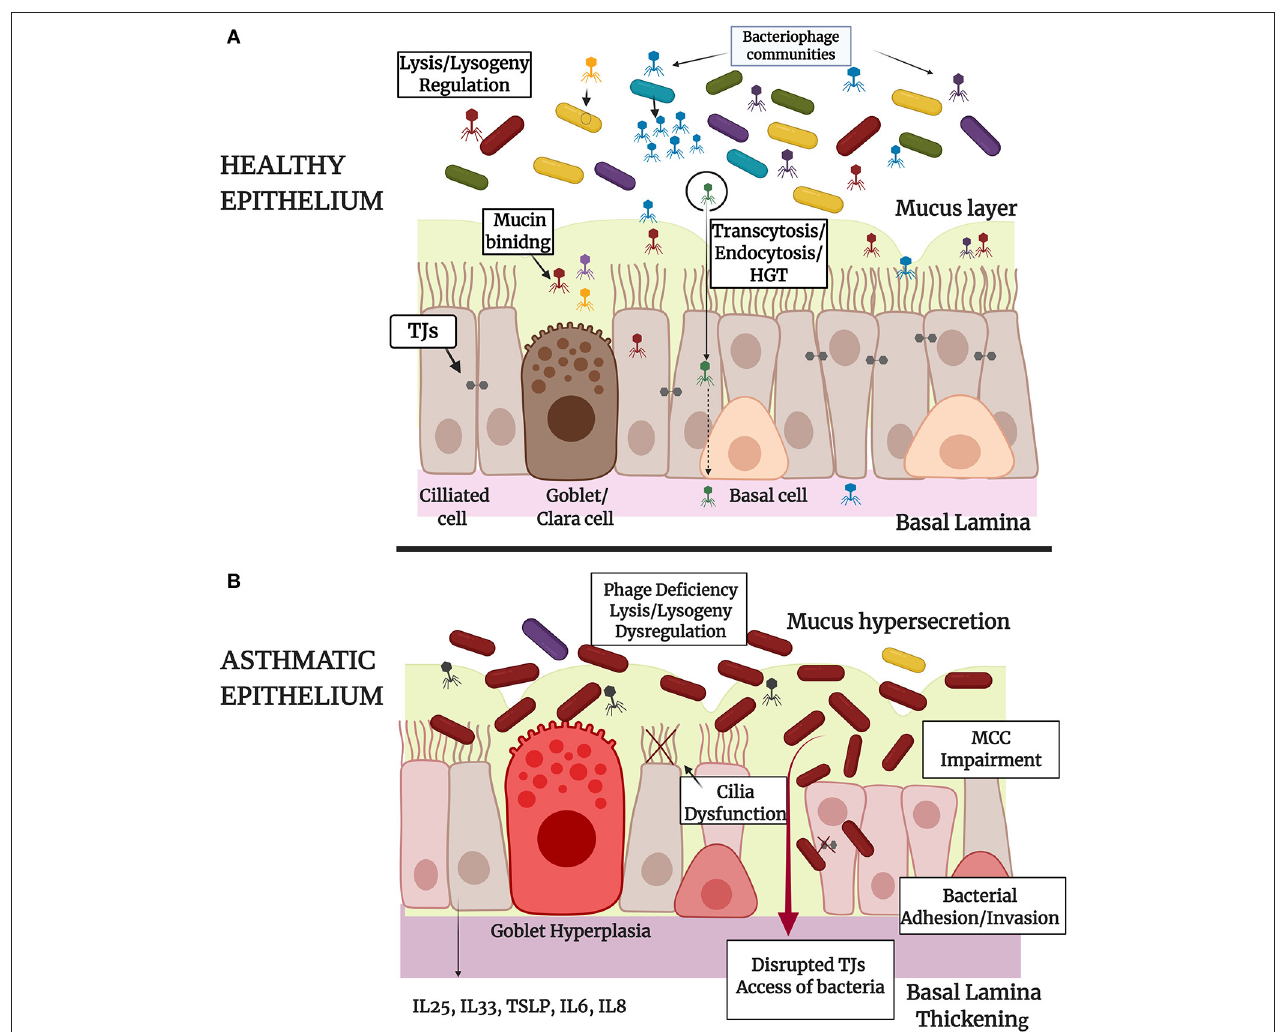
FIGURE 1 | Schematic representation of the tripartite symbiosis model between bacteriophages, bacteria and epithelium within healthy (A) and asthmatic (B) airways. (A) Healthy epithelium of large and small airways of the lungs is constituted by basal, ciliated and secretory Goblet (large airways) or Clara cells (small airways) that form pseudostratified or columnar and cuboidal structures, respectively. Epithelial barrier integrity is ensured by the formation of intracellular Tight Junctions (TJs) and by the secretion of mucus by Goblet or Clara cells. Healthy epithelium physically controls bacterial populations and eliminates bacterial invasion through mucociliary clearance (MCC). In healthy airways there is a diverse population of bacteria and bacteriophage communities that interact directly through lysis-lysogeny mechanisms and horizontal gene transfer as represented in the figure. Bacteriophages interact also directly with epithelium through adhesion to mucus or through specifically biding to cellular receptors (endocytosis) and non-specific binding to membrane vesicles (transcytosis). Bacteriophage-epithelium uptake protects the cells from bacterial invasion and proliferation and enables the delivery of bacteriophage nucleic acids (HGT) and proteins into the nucleus. (B) Asthmatic epithelium is characterized by Goblet hyperplasia, mucus hypersecretion, MCC impairment and disrupted TJs that lead to bacterial adherence and invasion into the human cells or access of bacteria into the lamina paracellularly. In the case of asthma, bacteriophage communities are deregulated, as it is presented in the figure, and this may be associated with an altered microbiota profile with limited bacterial diversity and dominance of specific bacterial species. The role of prophage elements in bacterial genomes has also an influence on the ability of pathogens to provoke infection and epithelial damage. Irritated asthmatic epithelium secretes a range of chemokines and cytokines, contributing to immune system activation and chronic inflammation in asthma. The image was created using